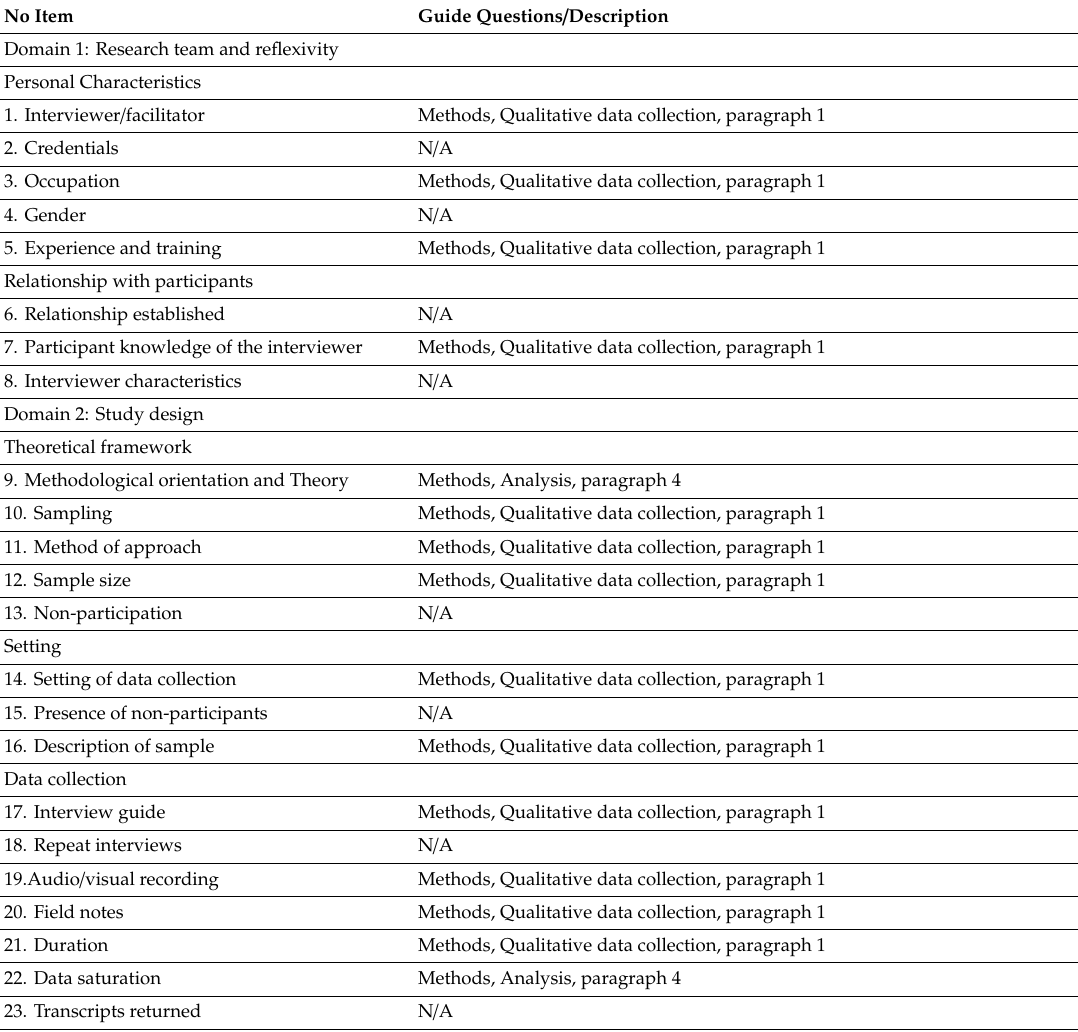
Table A2. Consolidated criteria for reporting qualitative studies (COREQ): 32-item